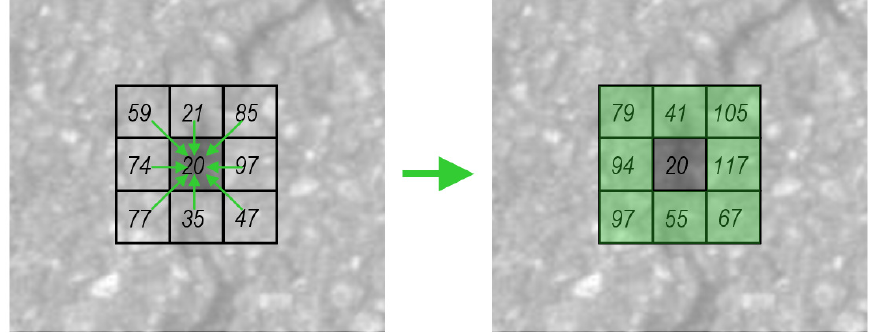
Figure 13. Initialization step. Left : backtracking information. Right : distance costs of the 8-connected pixels around the seed.